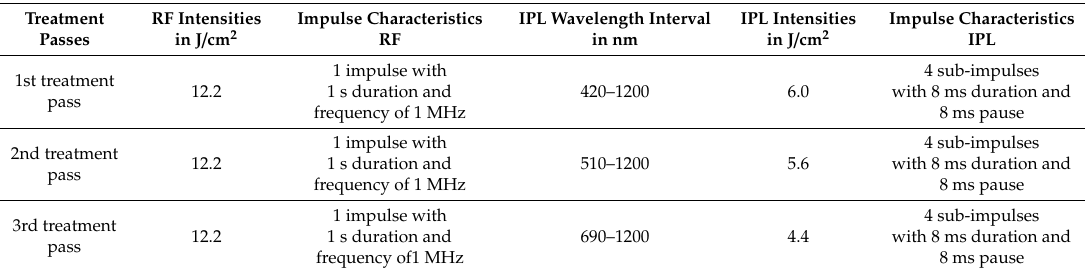
Table 1. Technical characteristics of LAight